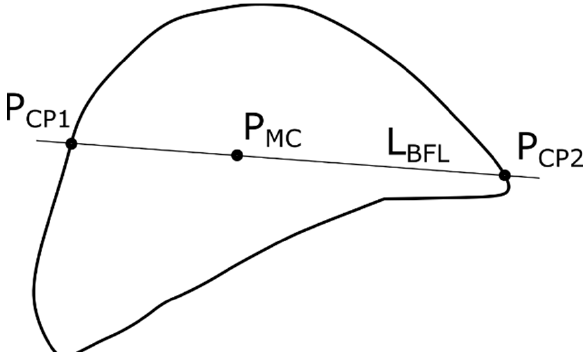
Figure 3. Analyzed points to determine the starting point for the contour descriptor. P MC is the pole, i.e., geometric center of mass of the contour, L BFL is the best-fitting line of all contour points, and P CP1 and P CP2 are points at the intersection between the contour and line L BFL